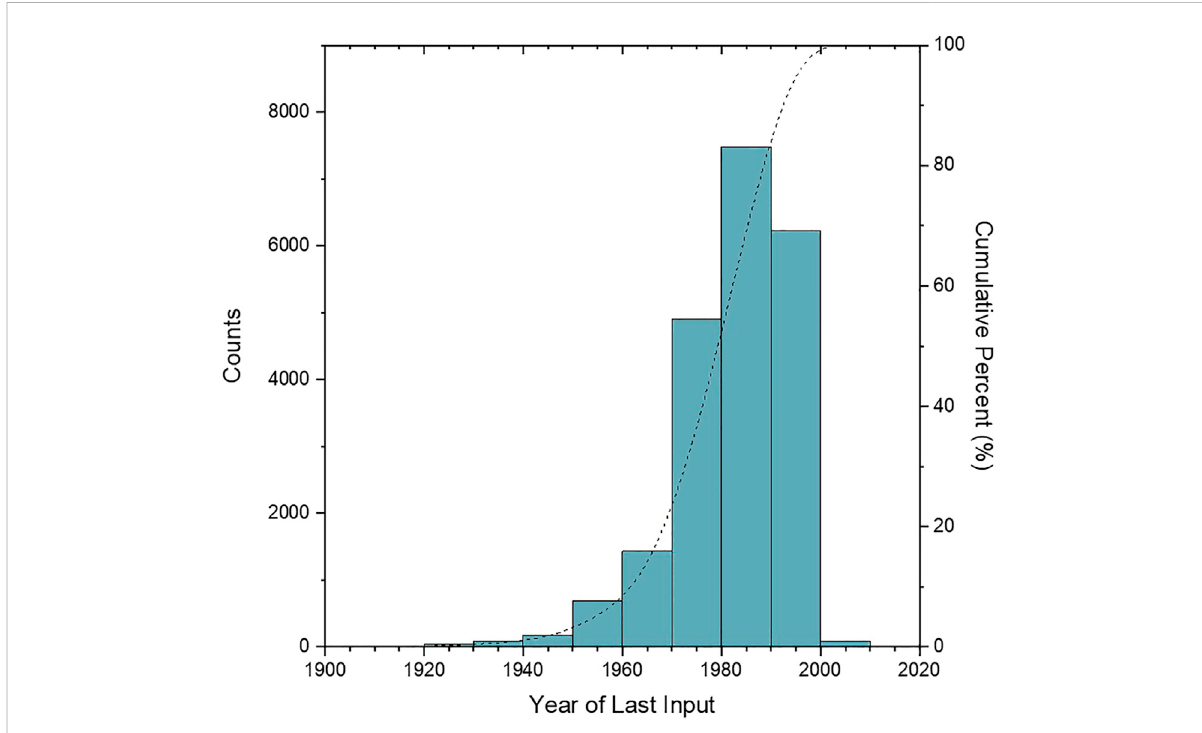
FIGURE 4 Year of last input for land fi ll sites within the legacy waste database (note that dates of last waste input were unavailable for coal and metal mine spoil